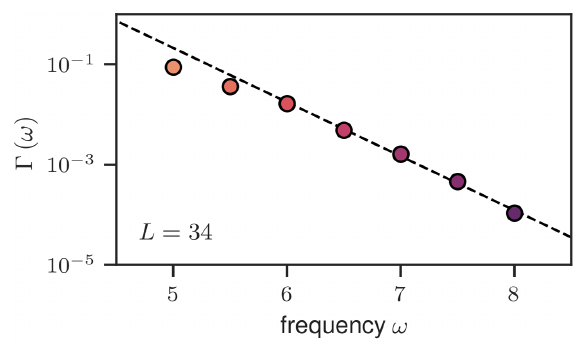
FIG. 4. The thermalization rate versus the frequency. The marker colors match the corresponding curves in Fig. 3 and are a redundant encoding of ω , indicated on the horizontal axis. The dashed line is a fit excluding the two leftmost points and results in (cid:9) = exp ( a ω + b ) with a = − 2.48 ( 7 ) and b = 10.9 ( 5 ) . The thermalization rates are extracted as described in the main text.